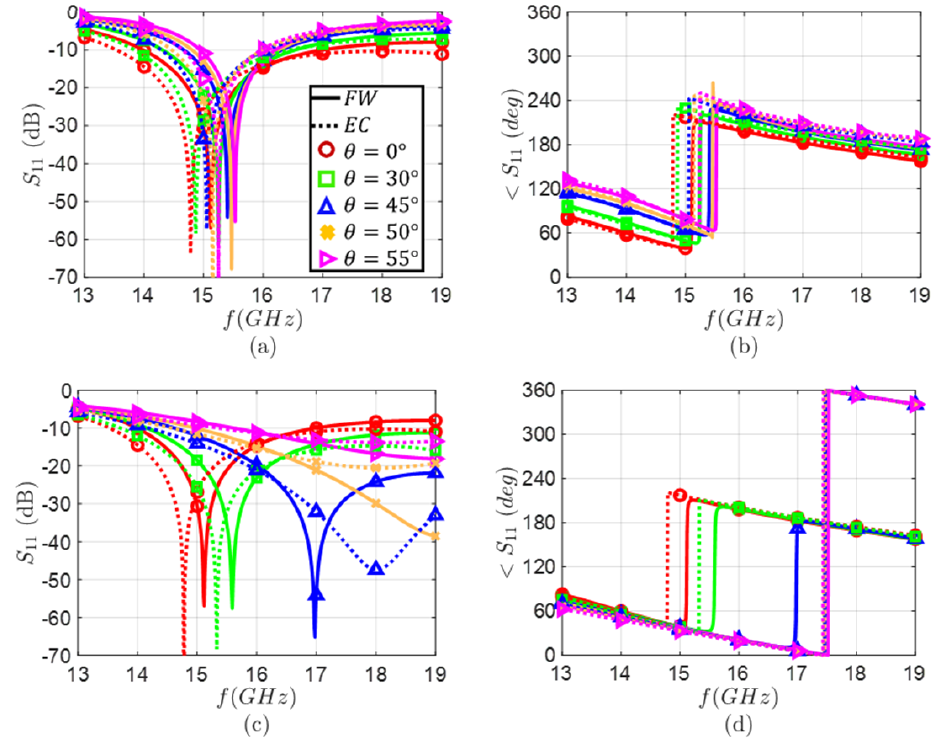
Figure 5. Reflection coefficient validation loaded unit-cell: ( a , b ) H-plane and ( c , d ) E-plane , magnitude and phase, respectively.